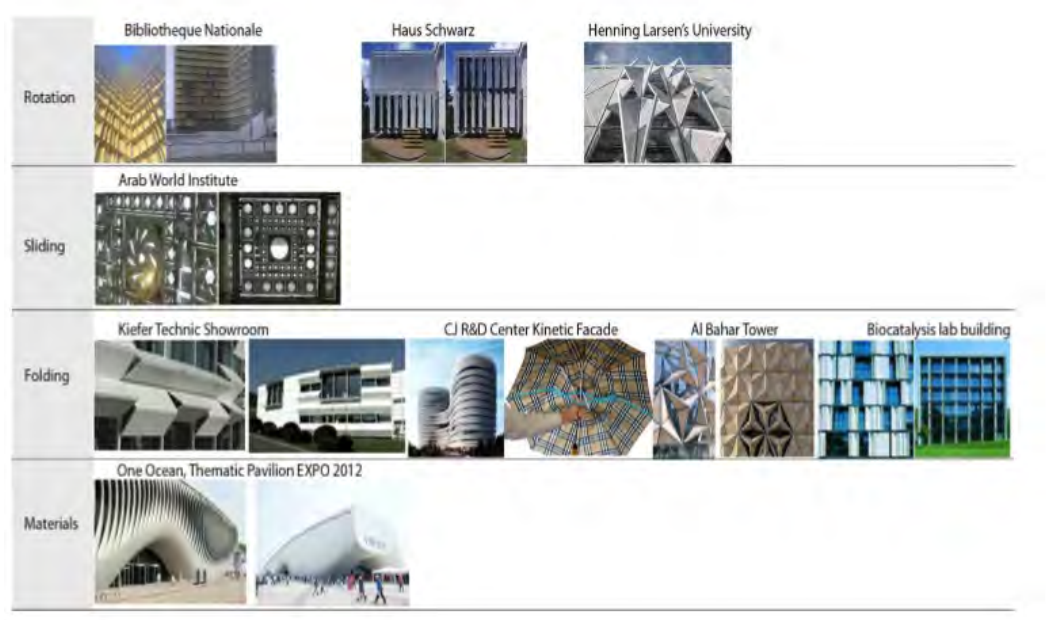
Figure 5. Examples of different kinetic facades’ motion and mechanism (source: El-Dbaa, 2016)